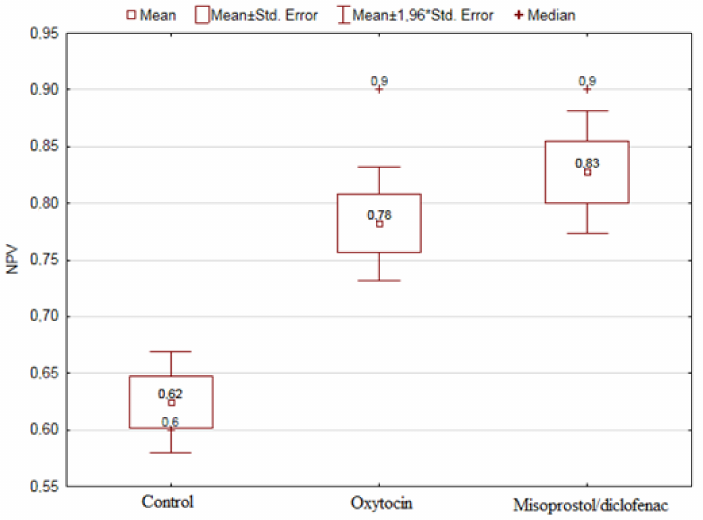
Figure 3. The effect of treatment drugs on NPV in patients with established washout gain